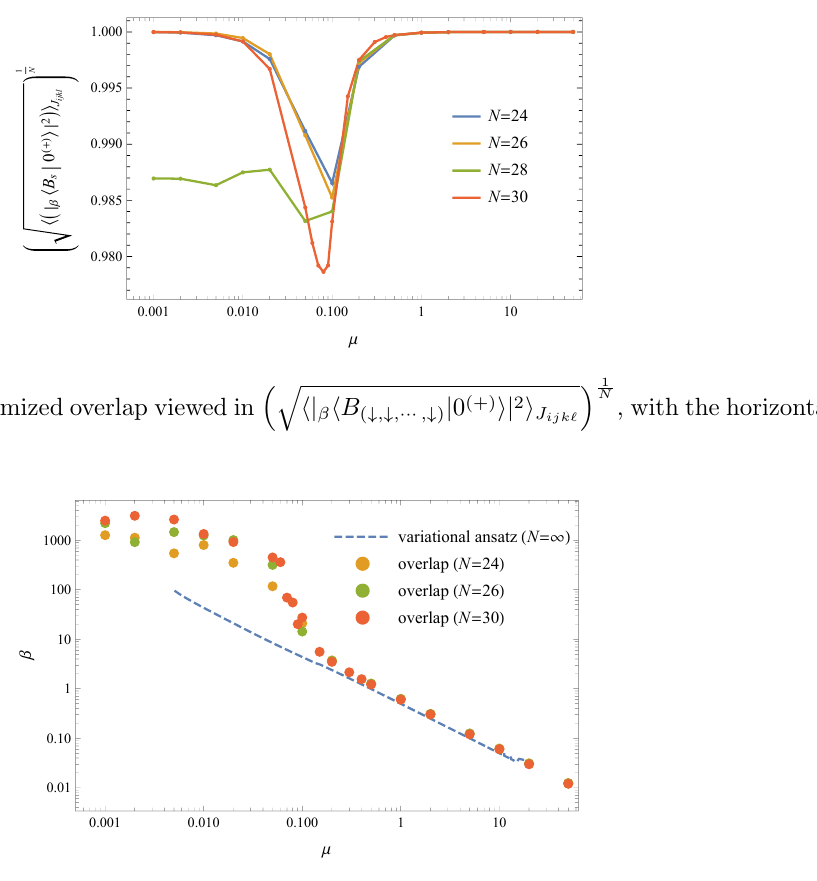
Figure 14 . The inverse temperature (cid:12) maximizing the overlap (4.4), averaged over the ensemble (cid:12) compared with the inverse temperature which minimizes the large N variational energy h i J ijk‘ (Blue; see (cid:12)gure 7 in section